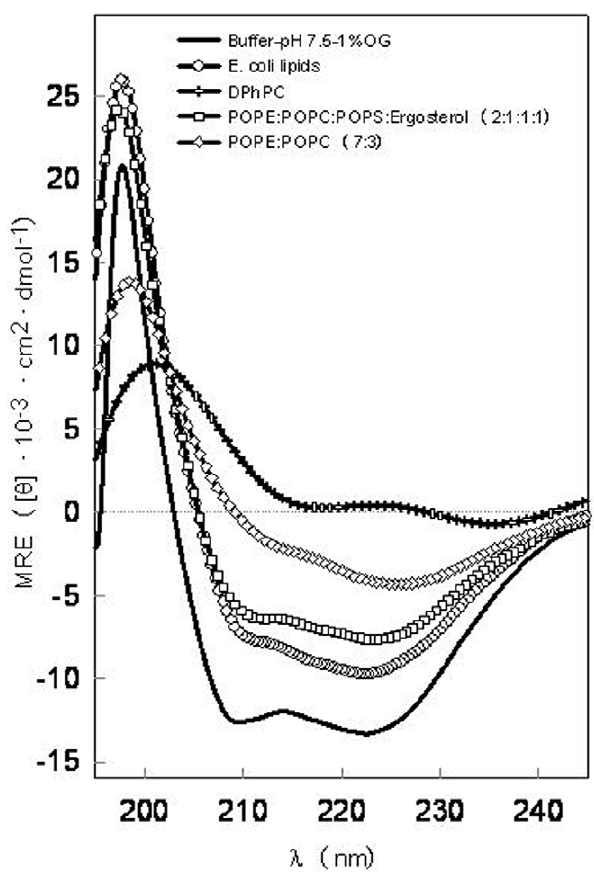
Figure 1. Far-UV CD spectra of SoPIP2;1. The measurements were obtained at 20 u C in phosphate buffer, pH 7.5, NaCl 150 mM containing 1% OG and in different lipid membranes.